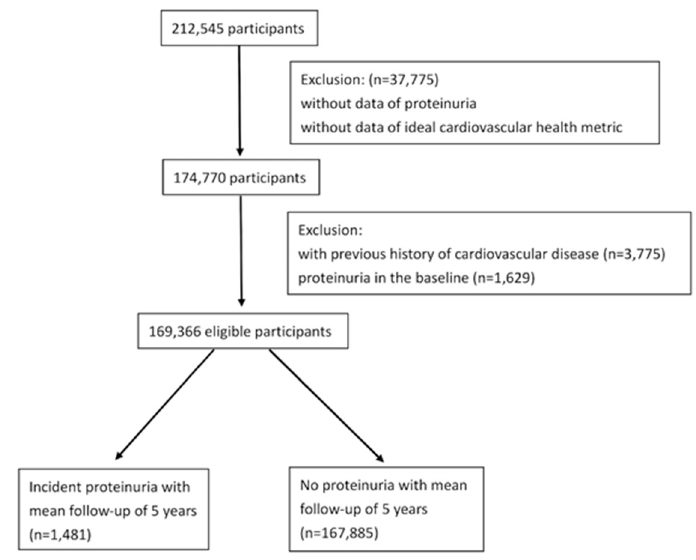
Figure 1. Flowchart of the selection procedure.